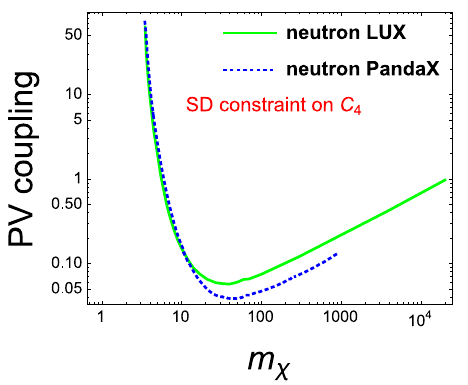
Figure 4 . Constraints on the coupling C 4 from the LUX result of spin-dependent DM-nucleon cross